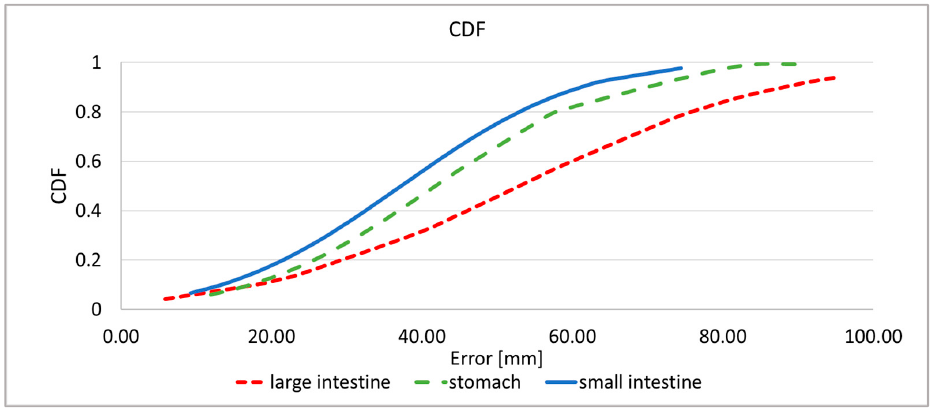
Figure 19. Cumulative distribution function (CDF), error comparison for different part of the digestive tract.